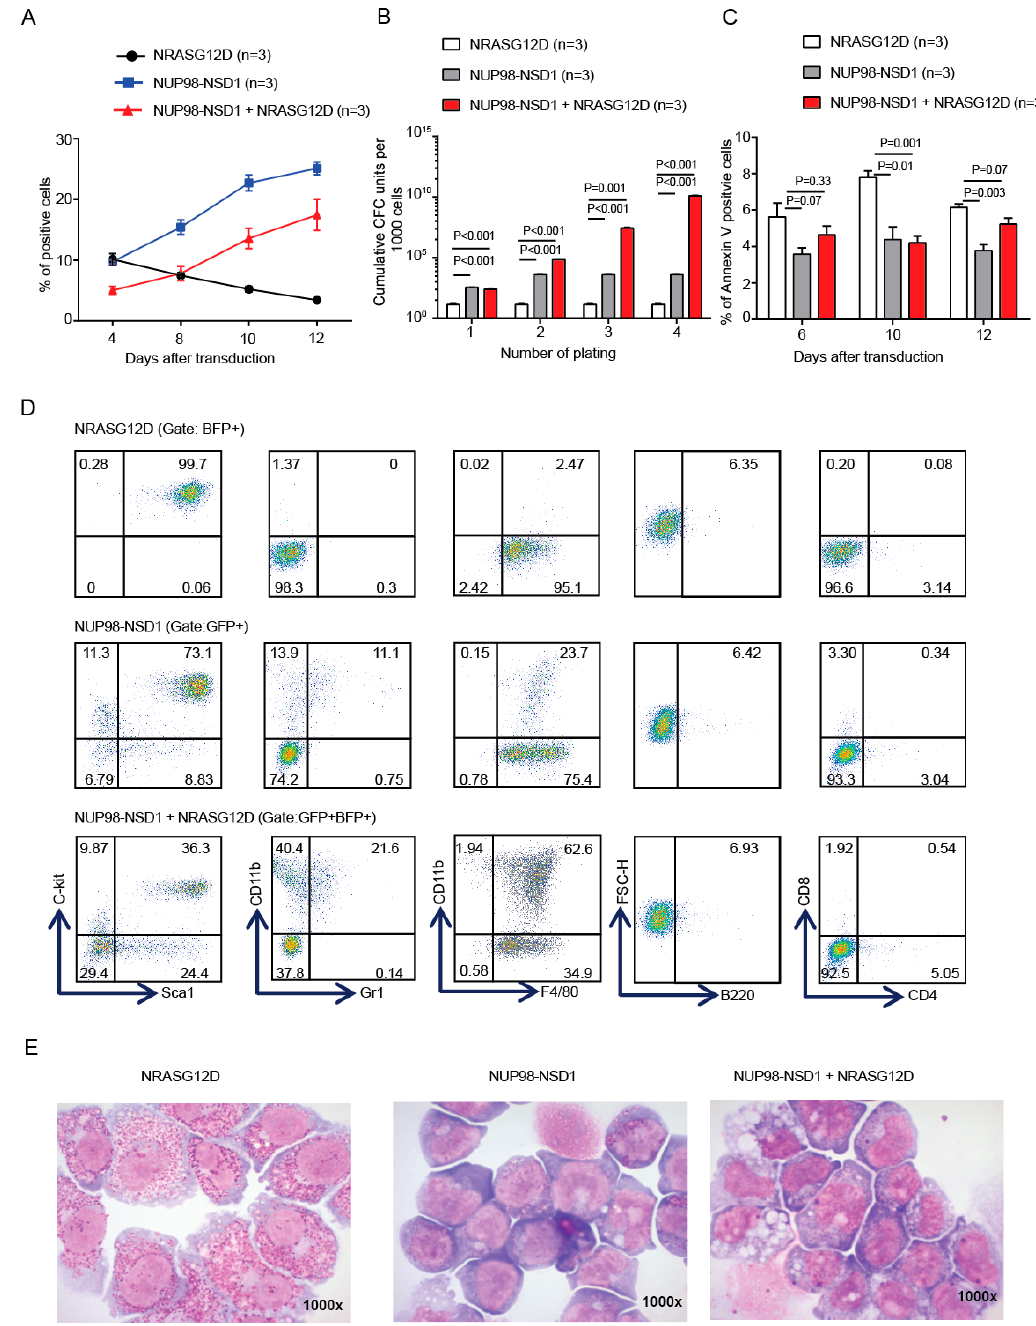
Figure 1. NUP98-NSD1 immortalizes murine hematopoietic cells and cooperates with mutated NRASG12D in vitro . ( A ) Percentage of 5-fluorouracil (5-FU)-treated bone marrow cells that were transduced with either NRASG12D-BFP, NUP98-NSD1-GFP, or both NUP98-NSD1-GFP and NRASG12D-BFP from day 4 to day 12 after transduction (mean ± SEM). ( B ) Cumulative Colony-forming cell unit (CFU) yield is shown for an initial plating of 1000 NRASG12D, NUP98-NSD1, or NRASG12D + NUP98-NSD1 transduced cells (mean ± SEM). ( C ) Percentage of apoptotic cells transduced with NRASG12D, NUP98-NSD1, or NRASG12D+NUP98-NSD1 until 12 days after transduction (mean ± SEM). ( D ) Representative immunophenotype of cells transduced with NRASG12D, NUP98-NSD1, or NRASG12D + NUP98-NSD1. ( E ) Representative Wright–Giemsa–stained cytospin preparations of NRASG12D, NUP98-NSD1, and NUP98-NSD1+NRASG12D transduced mouse bone marrow cells (1000x).